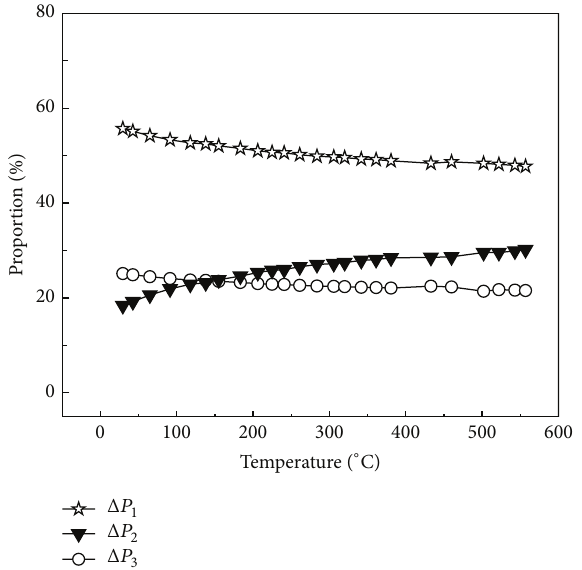
Figure 9: Contrast of the experimental results and the calculated results in the heat exchanger preheating